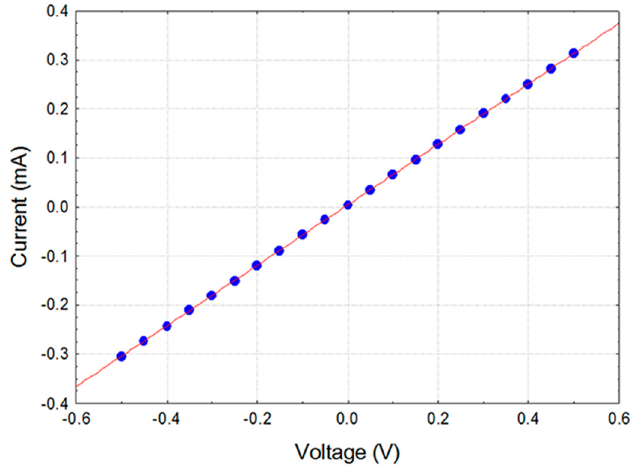
Figure 6. Current–voltage (IV) characteristics for the chemosensitive resistor coated with PEG2000-carbon black composite.